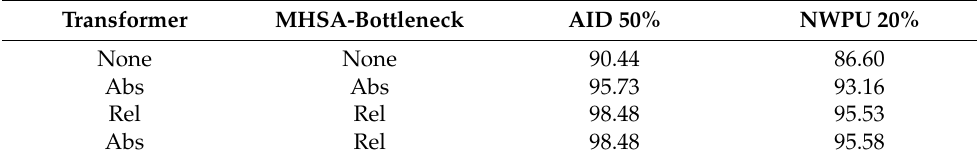
Table 14. Comparison of classification accuracy between two position embedding methods.